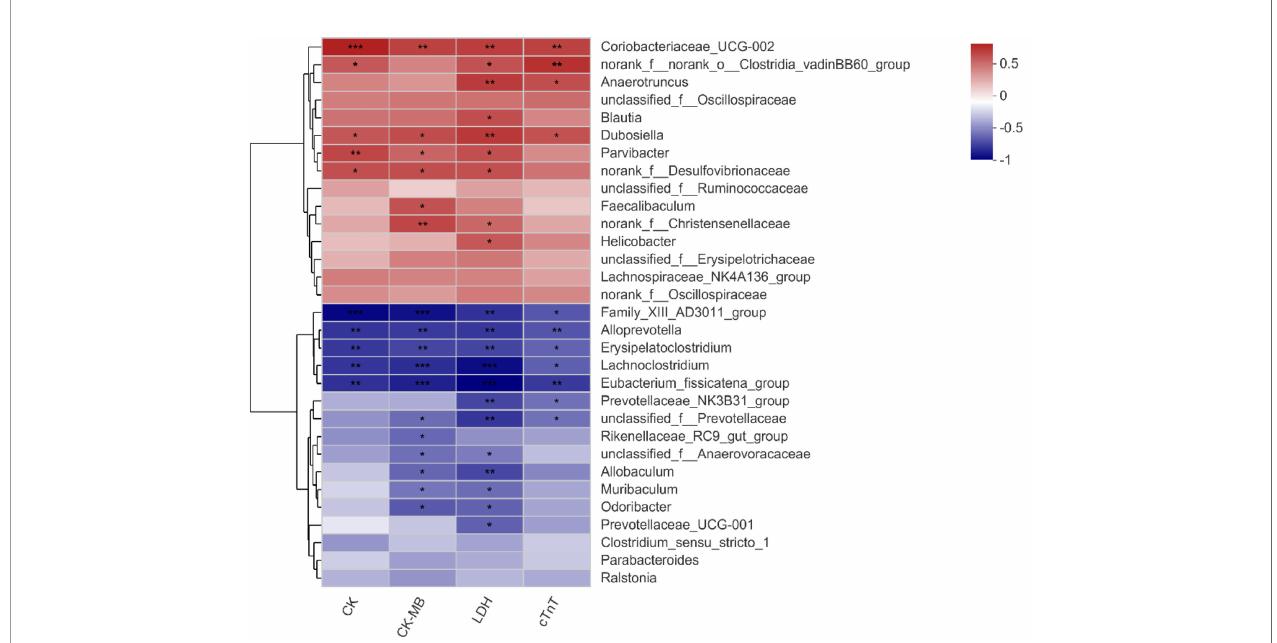
FIGURE 5 | Correlation heatmap of signi fi cantly different genera and clinical factors. The x- and y-axes are clinical factors and genera, respectively. R in different colors is shown; the right side of the legend is the color range of different R values. CK, creatine kinase; CK-MB, creatine kinase-MB; LDH, lactic dehydrogenase; cTnT, cardiac troponin T. n = 10. * p < 0.05, ** p < 0.01, *** p <